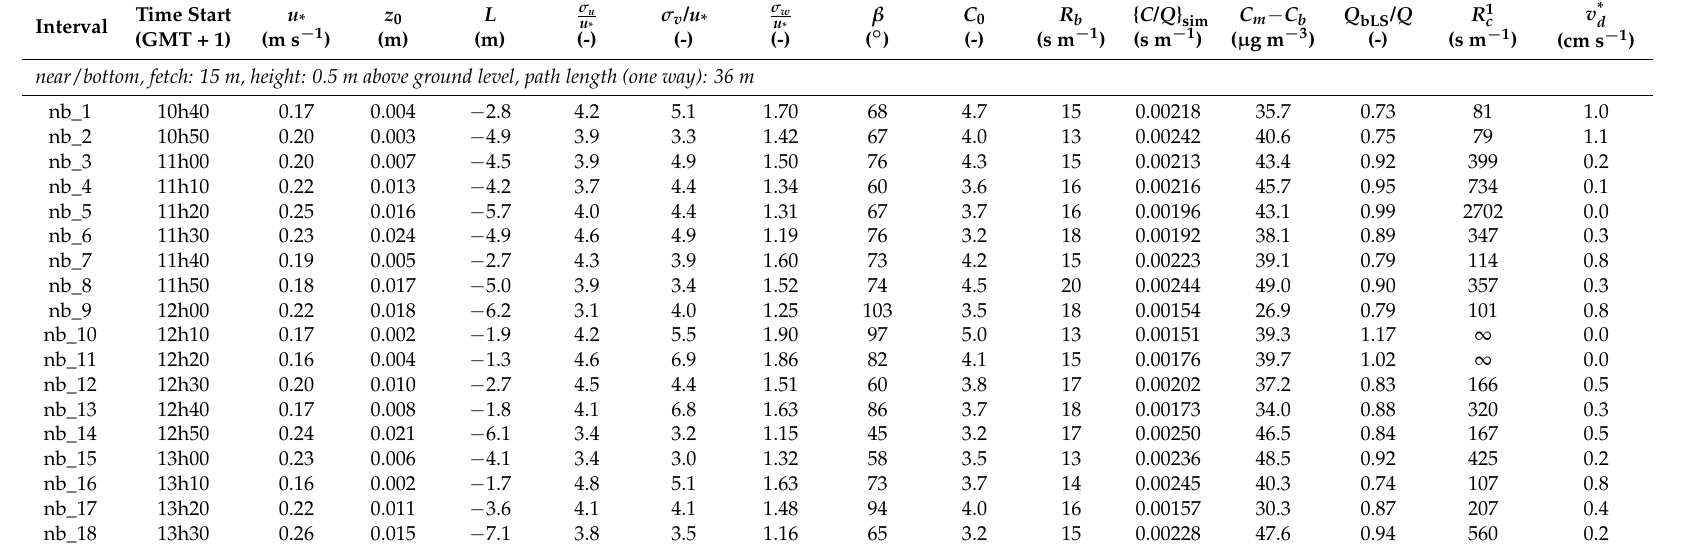
Table A1. Summary of the bLS input parameters, concentration averages and modelled results for each instrument location and each 10-min interval. u ∗ : friction velocity; z 0 : roughness length; L : Obukhov length; σ x / u ∗ : scaled standard deviation of the along-wind ( u ), crosswind ( v ) and vertical ( w ; at Sonic height 1.25 m) wind velocity component; β : wind direction; C 0 : Kolmogorov coefficient; R b : pseudo-laminar boundary layer resistance; { C / Q } measured NH 3 concentration; C b : NH 3 background concentration; Q bLS / Q : recovery rate; R 1 c : canopy resistance that provided estimates of Q bLS / Q closest to 1